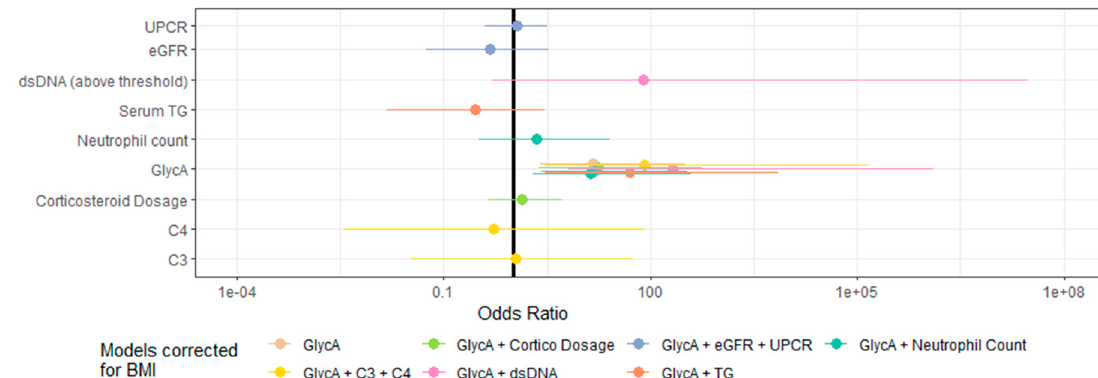
Figure 6. Multivariate logistic regression models for proliferative status in patients with biopsy-proven lupus nephritis. Logistic regression on samples from patients with non-proliferative ( n = 10) and proliferative ( n = 26) Lupus Nephritis, taken at time of renal biopsy, illustrates GlycA’s independence from other biological and immunological parameters. All multivariate models were corrected for BMI, considering its known association to GlycA and the significant difference observed between patients with proliferative and non-proliferative LN in our cohort (Table 2). Continuous variables were standardized prior to model construction.